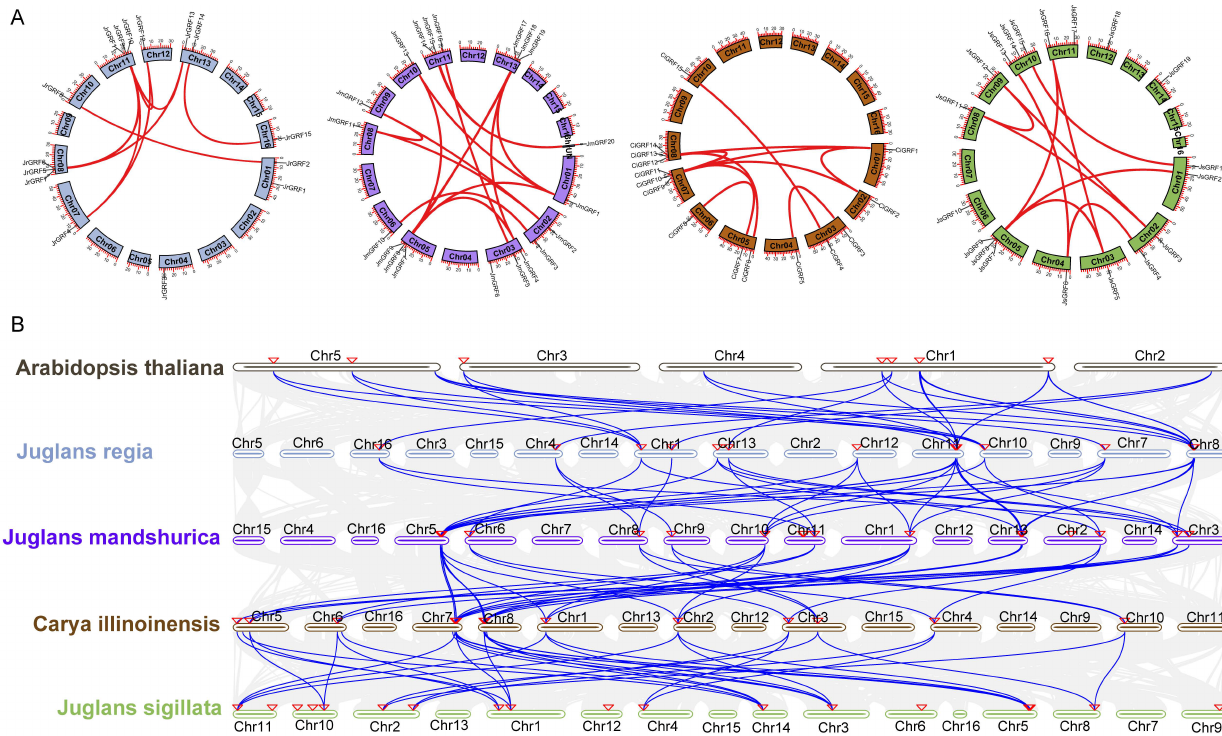
Figure 3. ( A ) Collinearity of segmental duplication gene pairs of GRFs in four Juglandaceae species. ( B ) Collinearity between Arabidopsis thaliana and four Juglandaceae GRF gene families. The red lines represent the segment duplication (SD) gene pairs of the GRFs .